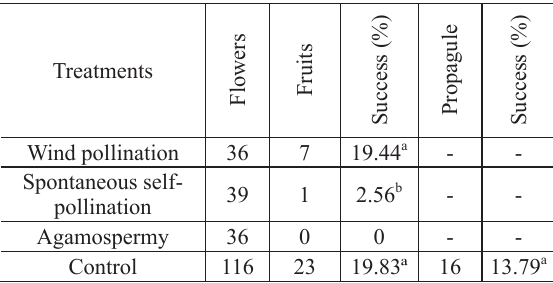
Fig. 3 - Stigma receptivity in flowers of Rhizophora mangle L. (Rhizophoraceae) on the first (A) , second (B) , third (C) and fourth (D) days of anthesis, showing pollen tubes (arrows) germinating only on the third and fourth days. Bar = 0.1